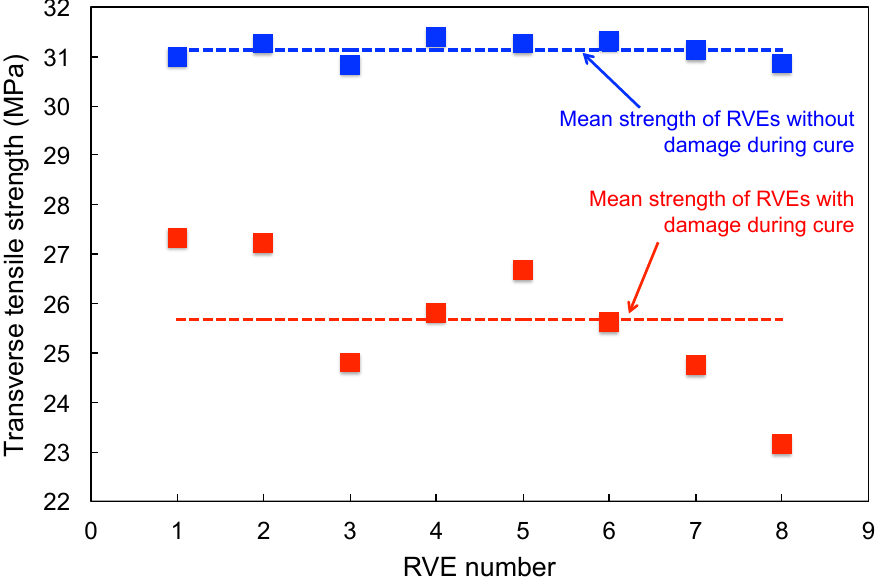
Figure 4. Variation in unit cell transverse tension strength (D’Mello et al.